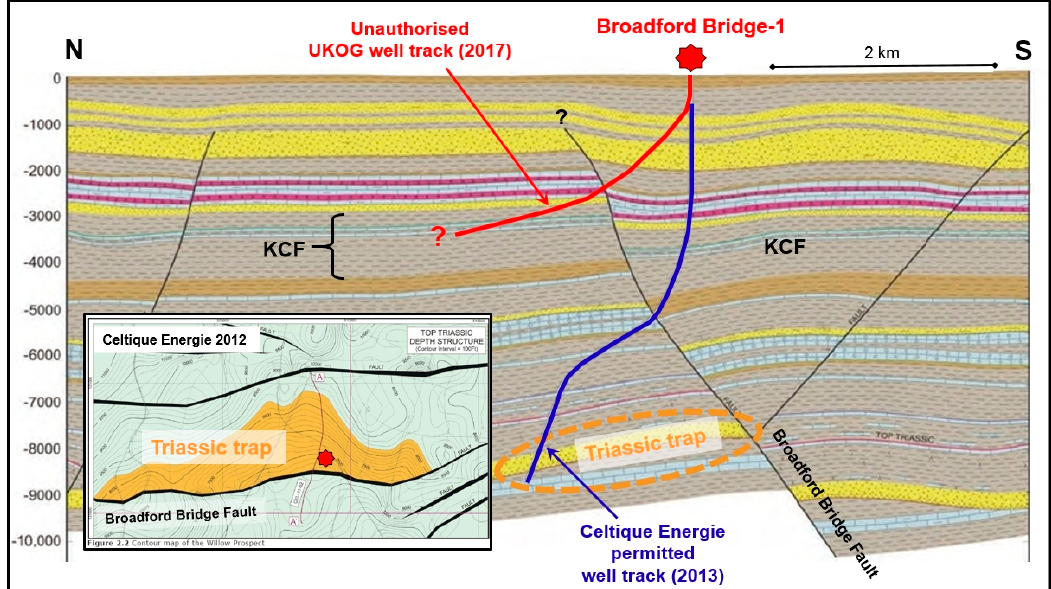
Figure 5. North–south geological cross-section through the Broadford Bridge-1 well drilled by UKOG in 2017. Vertical scale is shown in feet. The MPA-permitted well track of Celtique Energie is shown in blue; the approximate track of the unauthorised well drilled by UKOG in 2017 is shown in red. The inset map shows the structure map of the Triassic trap named ‘Willow’ by Celtique Energie.